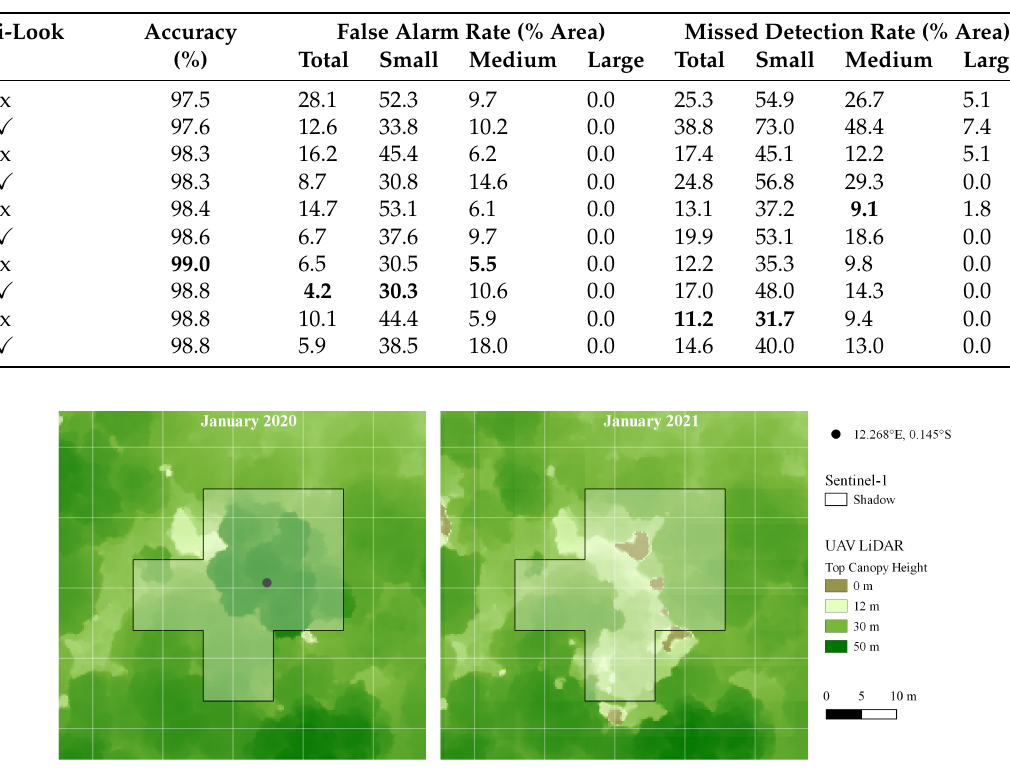
Table A1. Area based accuracy of Sentinel-1 shadow at detecting canopy gaps in 310 ha of forest, 5.2% of which was classified as disturbed from multi-temporal UAV LiDAR data. The canopy gaps are split into small (0.01 to 0.05 ha, N = 134), medium (0.05 to 0.1 ha, N = 90), and large (0.1 to 0.5 ha, N = 37). Results are shown according to how many post-event images were made available ( n ). A further distinction is made between results with or without a 3 × 3 multi-looking filter, and the best results are highlighted in bold.